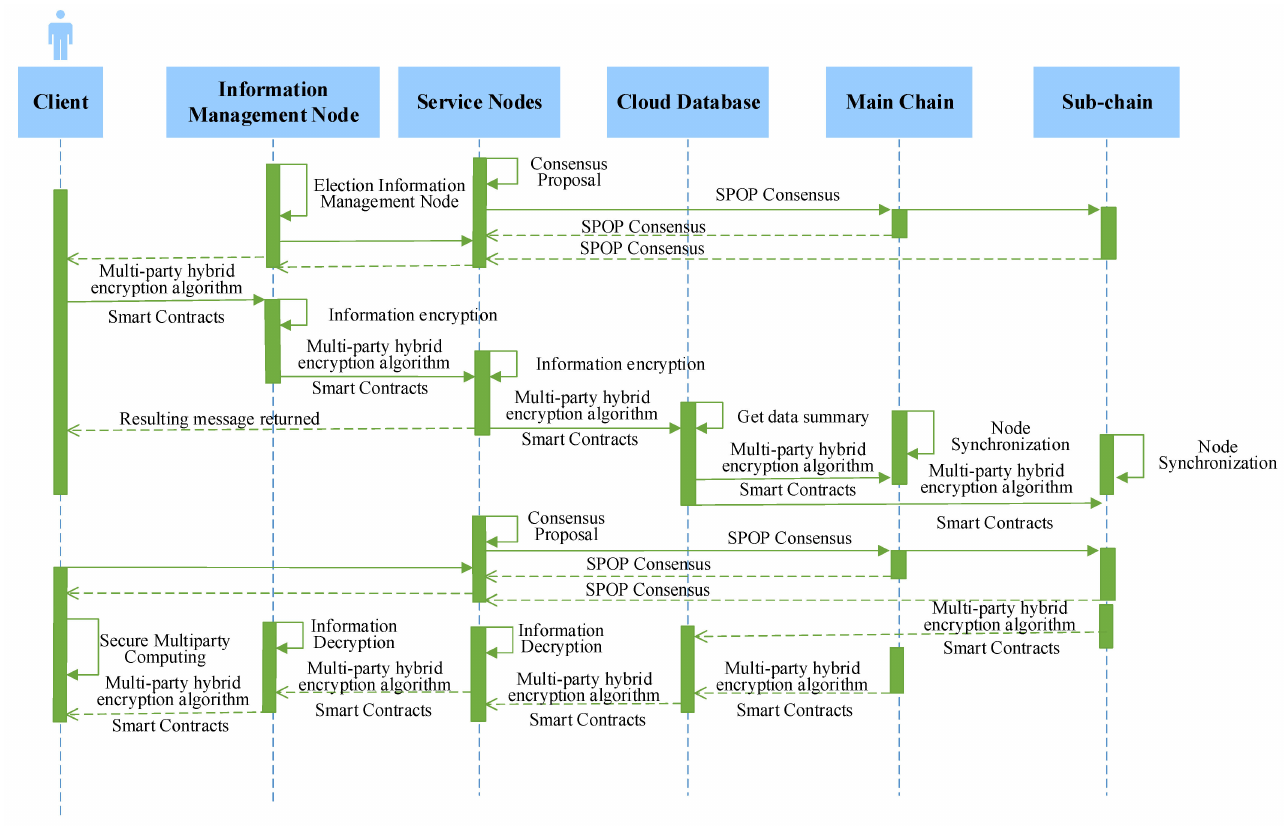
Figure 6. MBRRSM Logic Timing